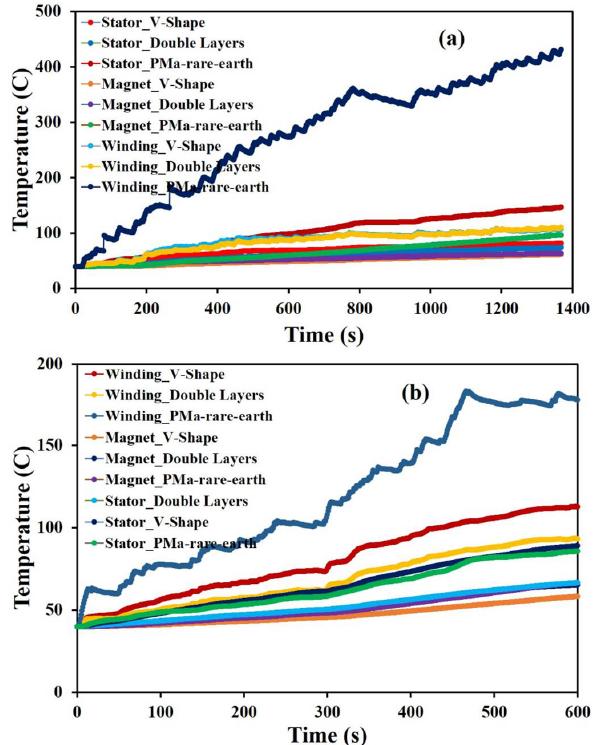
Figure 20. The temperature rise for winding and magnet: ( a ) UDDS, and ( b ) HWFET.